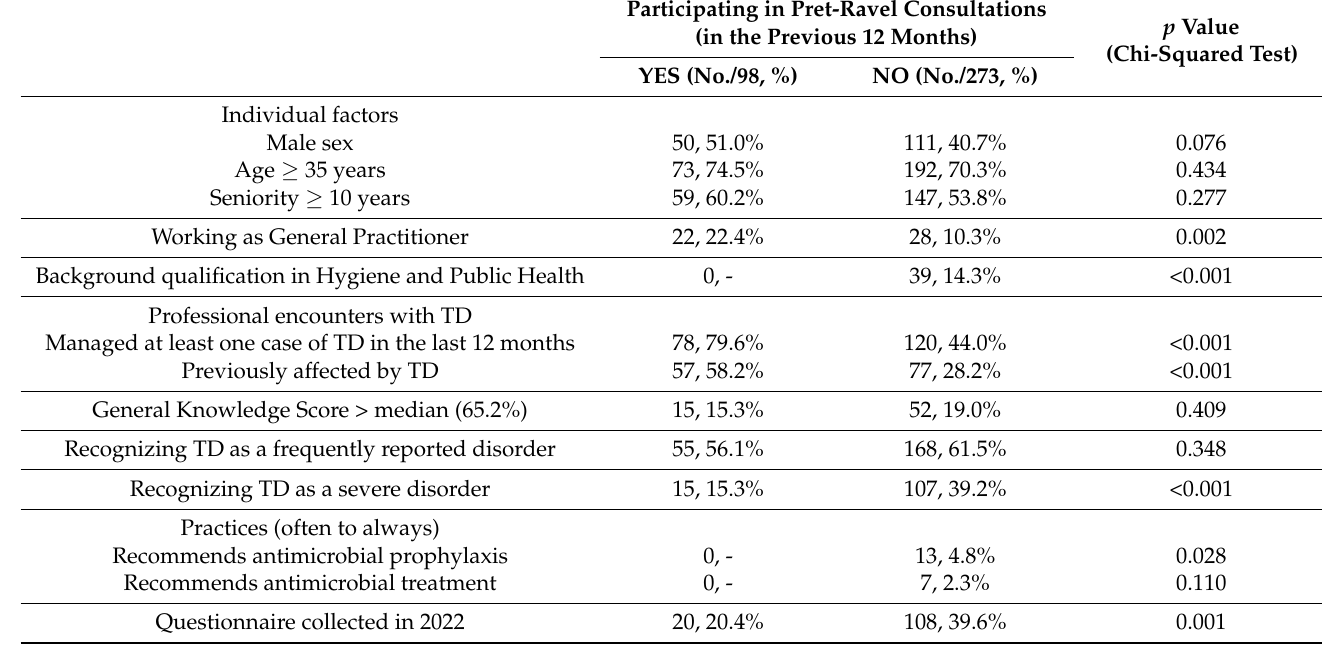
Table A4. Univariate analysis of individual factors associated with participating in pre-travel consul- tations (Note: TD = travelers’